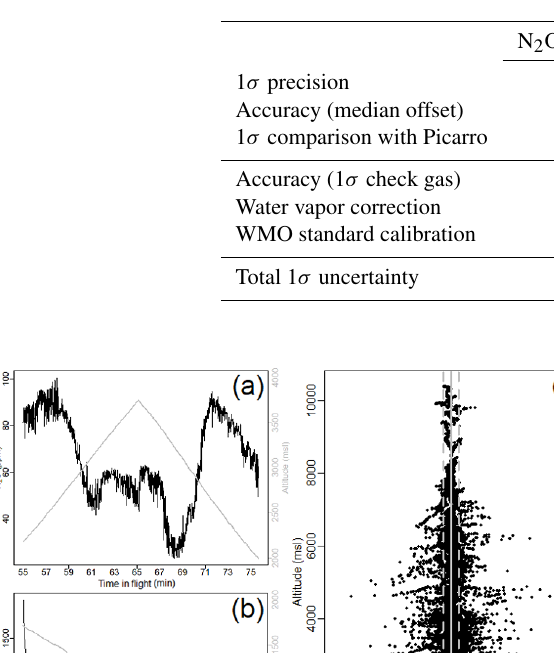
Table 1. Precision and accuracy for N 2 O, CO 2 , CO, and H 2 O.